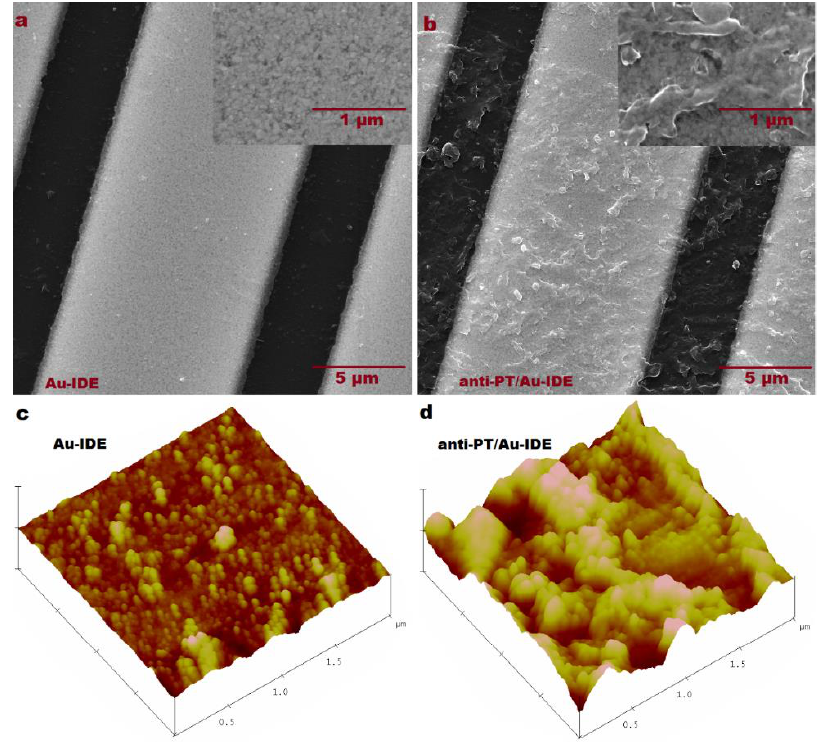
Figure 2. Surface morphological analysis of ( a ) Au-IDE and ( b ) anti-parathion/Au-IDE by SEM. Roughness analysis of ( c ) Au-IDE and ( d ) anti-parathion/Au-IDE by AFM.